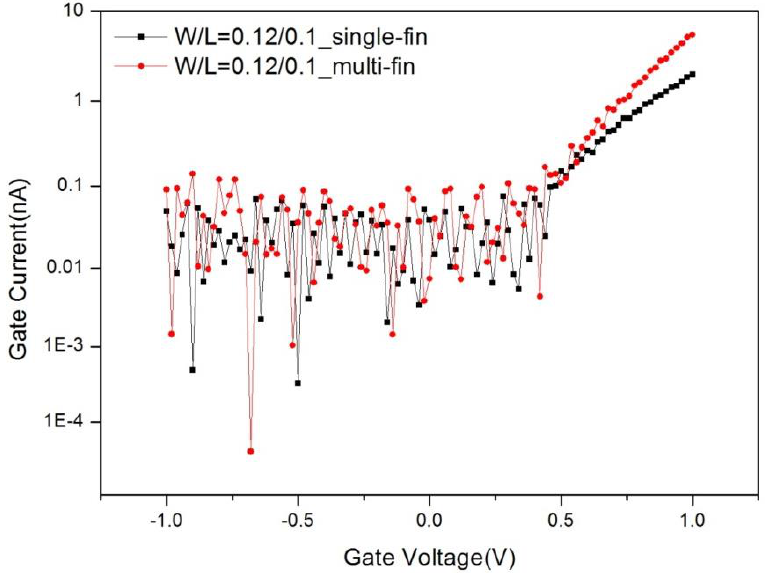
Figure 12. Gate leakage performance for single and multi-fin n-channel FinFETs as W / L = 0.12/0.1 (μm/μm) as S/D grounded.